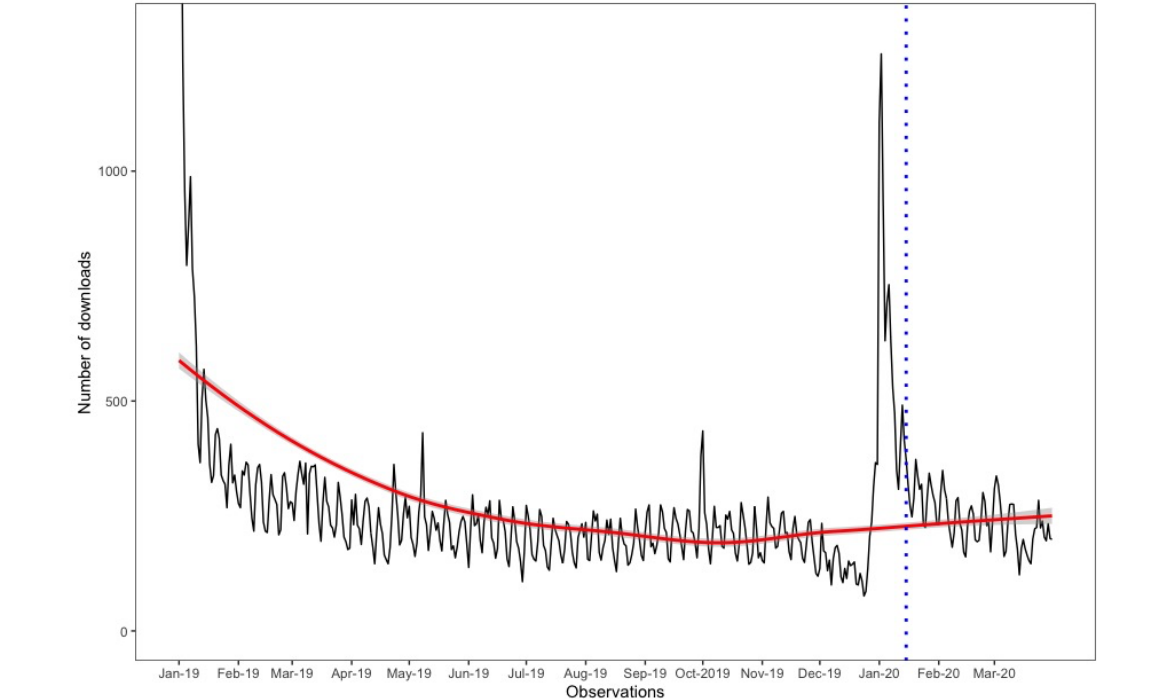
Figure 2. The number of users downloading the Smoke Free app from January 1, 2019, to March 31, 2020. The dotted blue vertical line represents the stipulated starting point of the severe acute respiratory syndrome coronavirus 2 outbreak (ie, January 15, 2020). The solid red line represents the fitted values with a loess smoothing function applied and associated 95% CIs. For clarity, the y-axis was capped at 1300